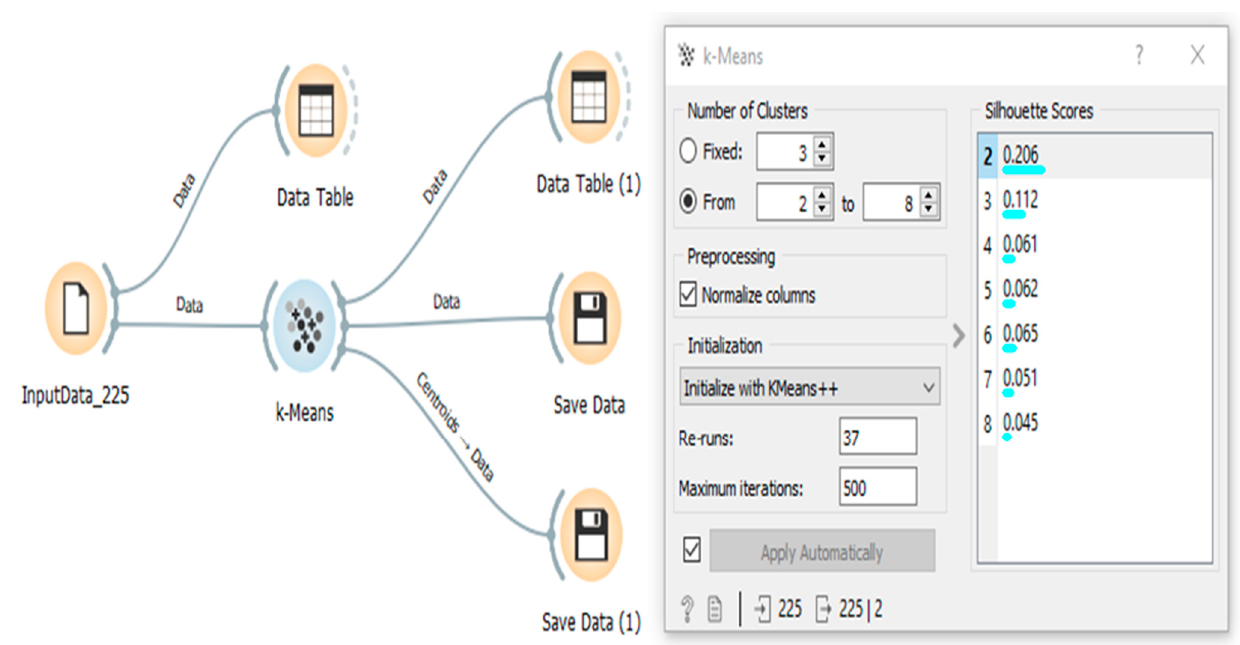
Figure 7. Workflow of best-fitted 1st-stage KM model.